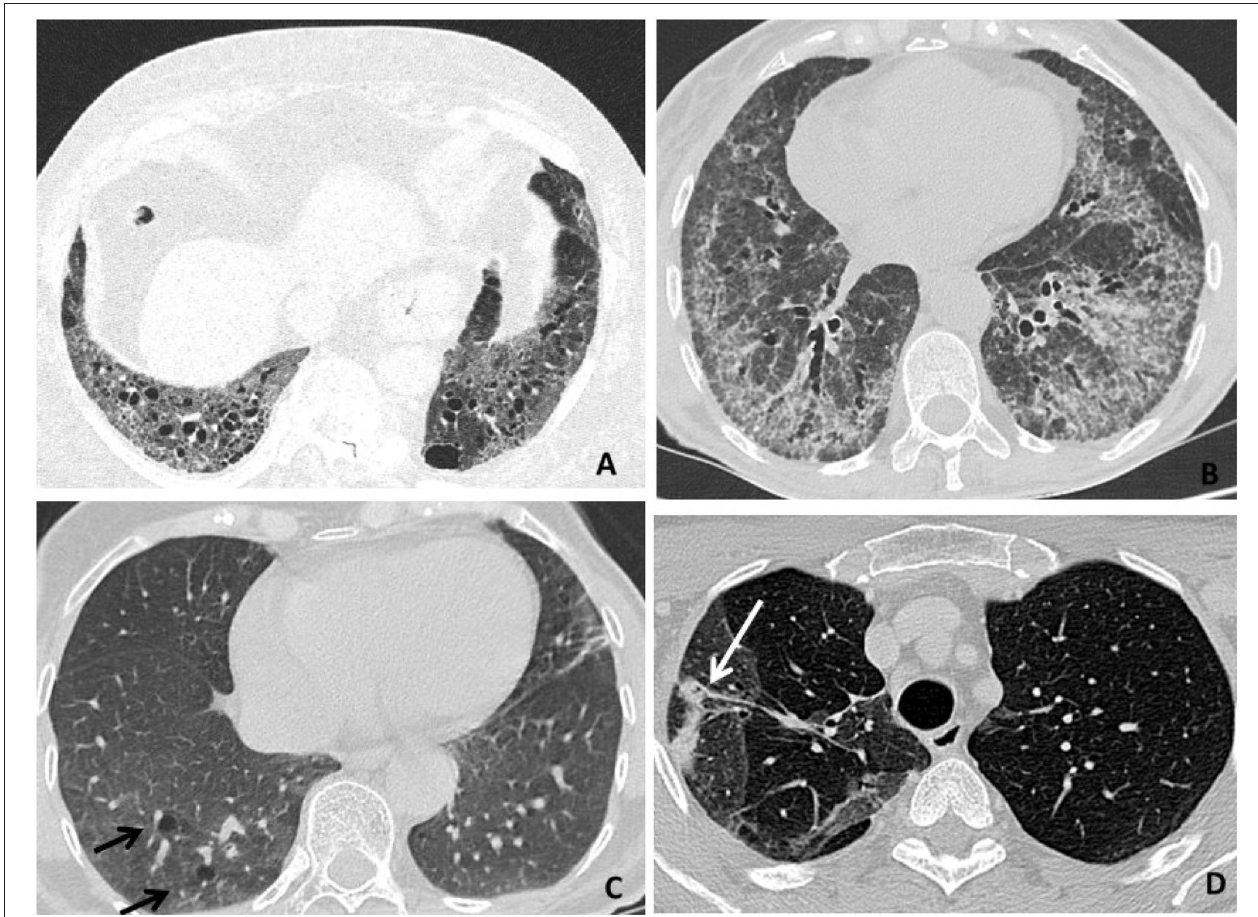
FIGURE 3 | High-resolution computer tomography (HRCT) findings in respiratory diseases and particularly interstitial disease (RA-ILD). (A) An usual interstitial pneumonia (UIP) pattern (representing the most typical radiological presentation in patients with RA) is primarily characterized by reticular fibrosis, traction BR, and subpleural cysts (honeycombing). (B) A nonspecific interstitial pneumonia (NSIP) pattern is primarily characterized by ground-glass opacities, variably mixed with septal thickening, and reticular fibrosis (fibrosing NSIP). (C) A lymphocytic interstitial pneumonia (LIP) pattern is primarily characterized by perivascular thin-walled cysts (black arrows). (D) An organizing pneumonia (OP) pattern is primarily characterized by pulmonary consolidations (a white arrow).